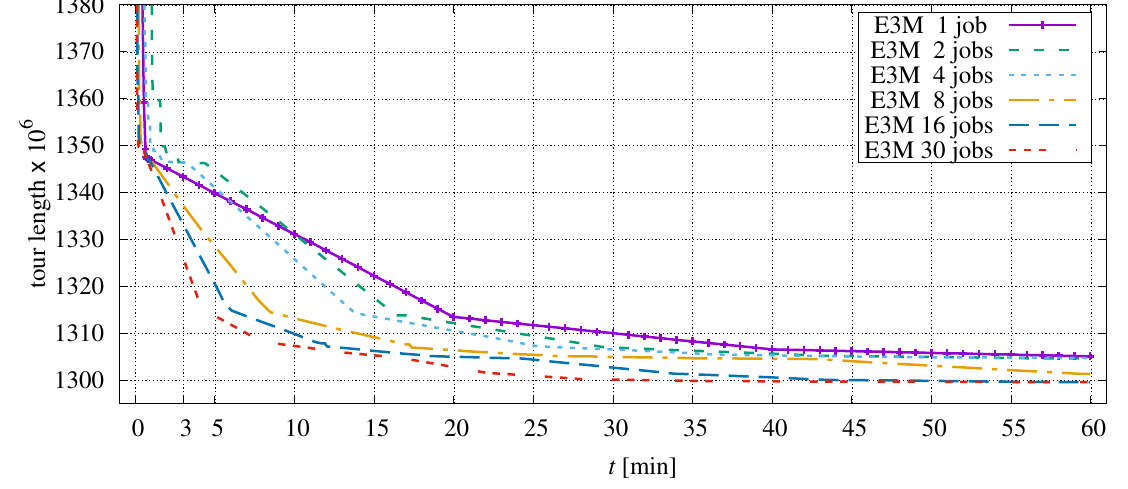
Figure 17. Progress of optimization dependent on the number of parallel jobs in application to E3M.0. The more segments are processed in parallel, the faster the tour length is improved.